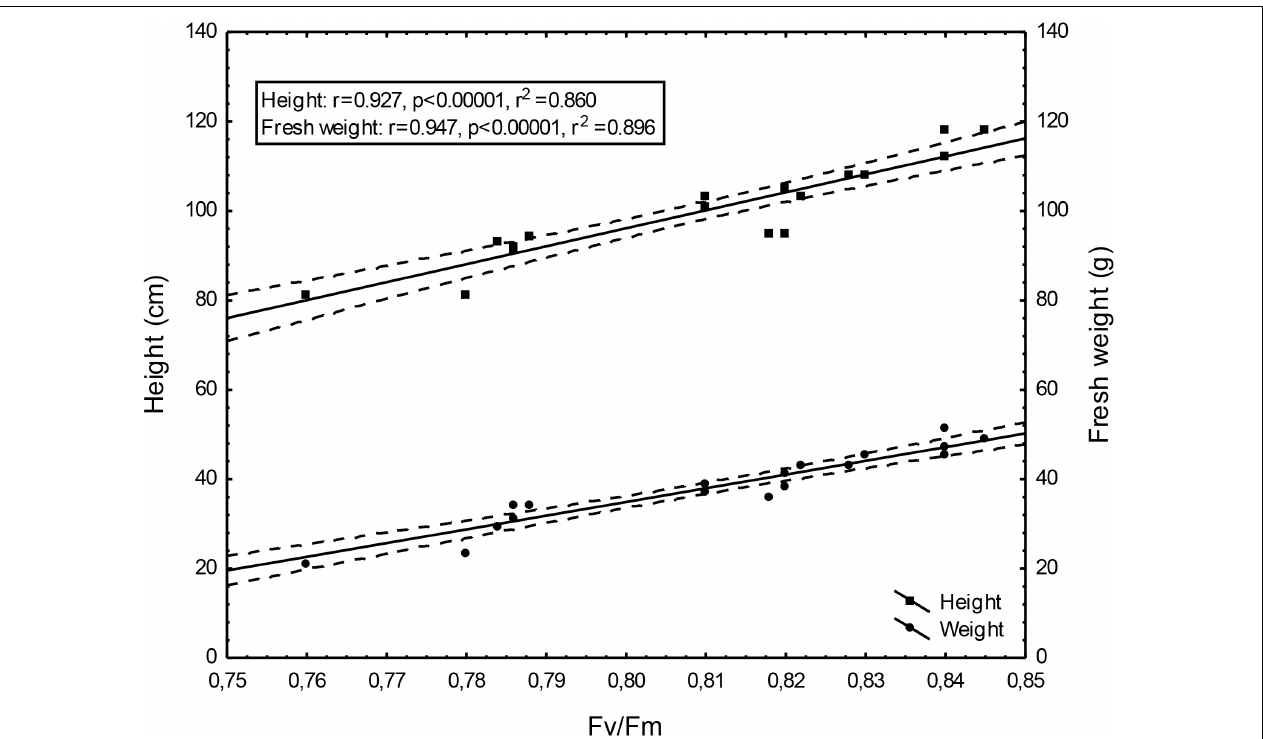
FIGURE 6 | Height and fresh weight regressions against Fv/Fm: Height = –225.22 + 401.68Fv/Fm; fresh weight = –210.50 + 306.77Fv/Fm; 0,95 C.L.